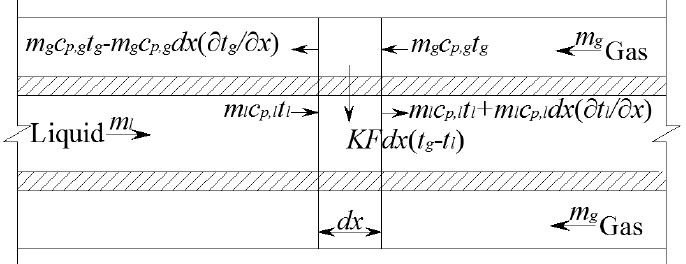
Figure 5. Heat exchanger calculation model. m g , m l : Gas and liquid flow rate, respectively. t g , t l : Gas and liquid temperature, respectively. K : Heat transfer coefficient of heat exchanger. F : Heat exchange area per unit length. c p,g , c p,l : Average specific heat of gas and liquid, respectively. dx : Micro–element